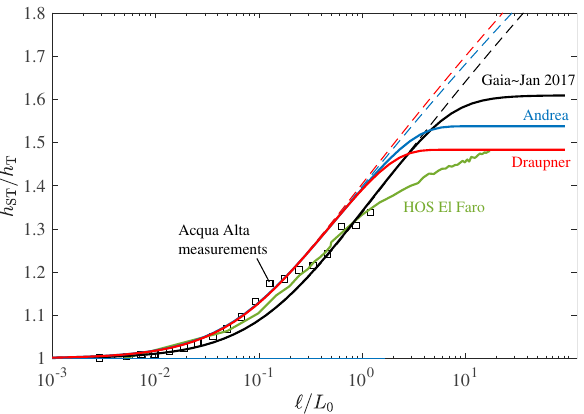
Figure 9. Space-time extremes: theoretical ratio h ST / h T as a function of the area width ℓ/ L 0 for El Faro, Draupner and Andrea rogue sea states as well as the sea states at the peaks of Gaia and Jan 2017 storms. h ST is the mean maximum surface height expected over the area ℓ 2 during a sea state of duration D h T is the mean maximum surface height expected at a point. For comparisons, the empirical ST ratio from the El Faro HOS simulations (green solid line) together with the experimental observations at the Acqua Alta tower (squares) are also shown 16 . L 0 is the mean wavelength. Dashed lines denote the unbounded Gaussian predictions, whereas solid lines denote the bounded predictions using Collins-Battjes method 45–47 with ξ max 1.55 =